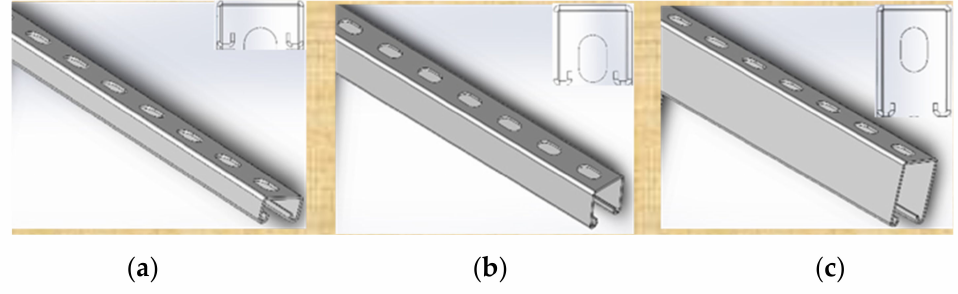
Figure 8. Profile cross-section types: ( a ) 40 mm × 20 mm; ( b ) 40 mm × 40 mm; ( c )—40 mm × 60